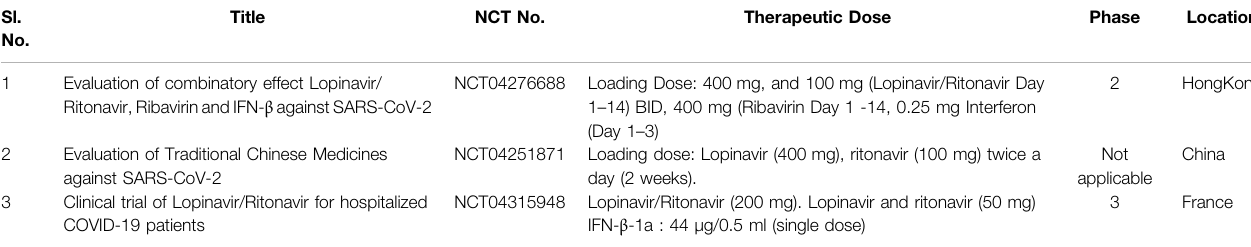
TABLE 5 | Running clinical trial studies for validation of Lopinavir/Ritonavir (https://clinicaltrials.gov/ct 2/results). Sl. No.